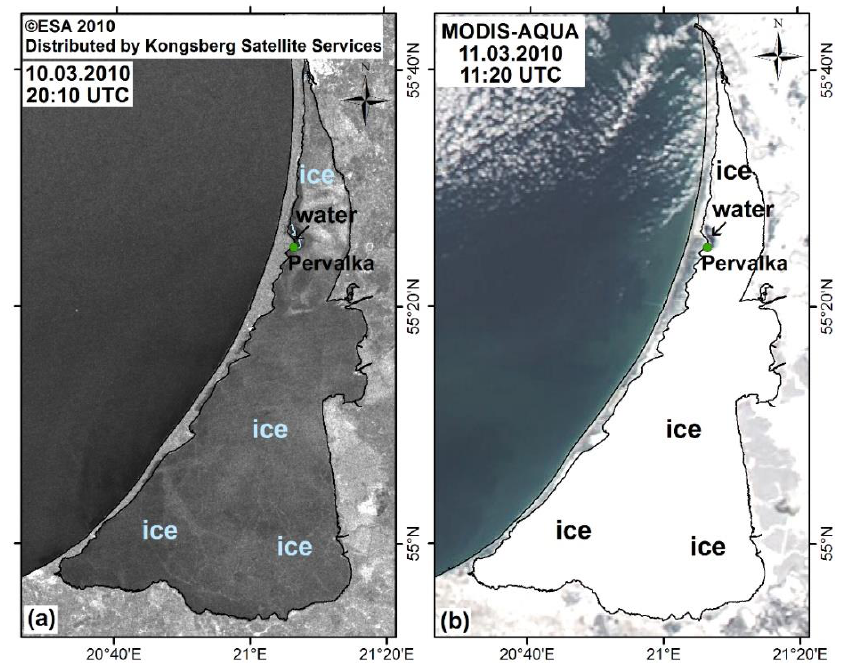
Figure 5. Start of ice break-up in the Curonian Lagoon as seen in ( a ) Envisat ASAR image acquired on 10 March 2010; ( b ) MODIS Aqua visible-band image acquired on 11 March 2010.